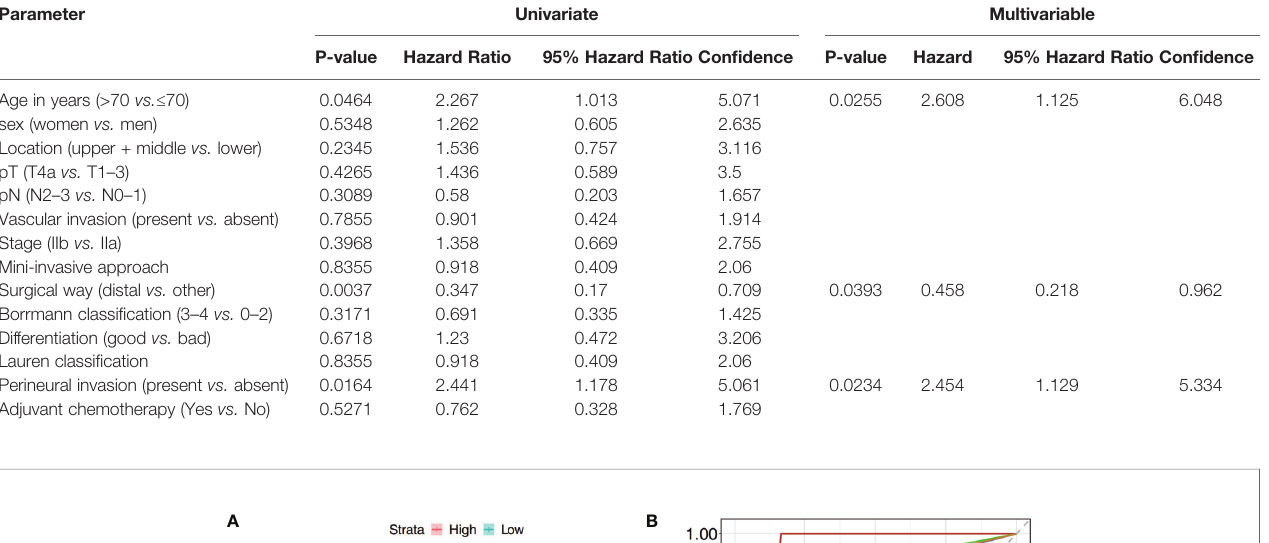
TABLE 2 | Univariate and multivariable Cox analysis of disease-speci fi c survival. Parameter Univariate Multivariable P-value Hazard Ratio 95% Hazard Ratio Con fi dence P-value Hazard 95% Hazard Ratio Con fi dence Age in years (>70 vs. ≤ 70)